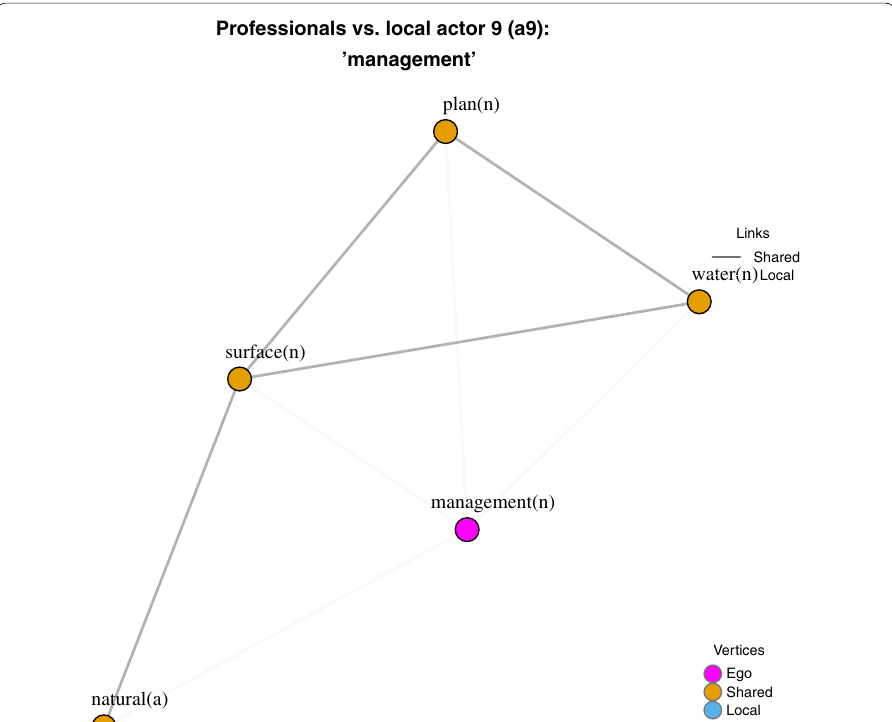
Fig. 5 Professionals versus local actor a9: “management”. Suffixes after the concept’s name show its part or speech: (n) noun, (v) verb, (a) adjective. For display purposes, only shared and local-specific concepts are shown. In case of “management”, the professional network contains 641 other concepts, while local actor’s network has only